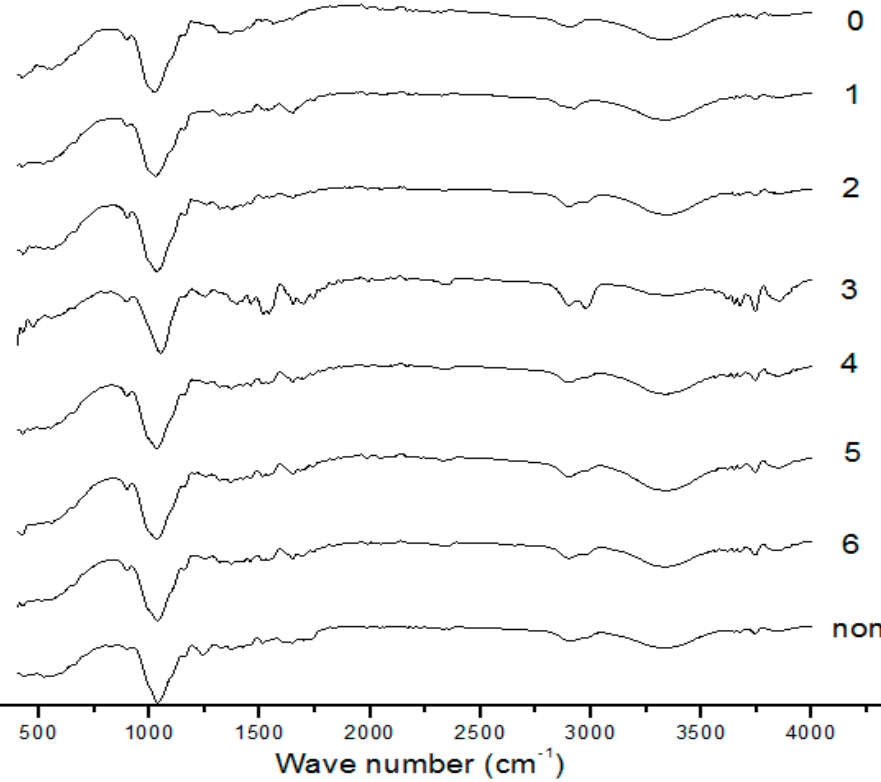
Figure 5. FTIR of untreated straw and straws treated with alkaline black liquor circulation with different times. di ff erent